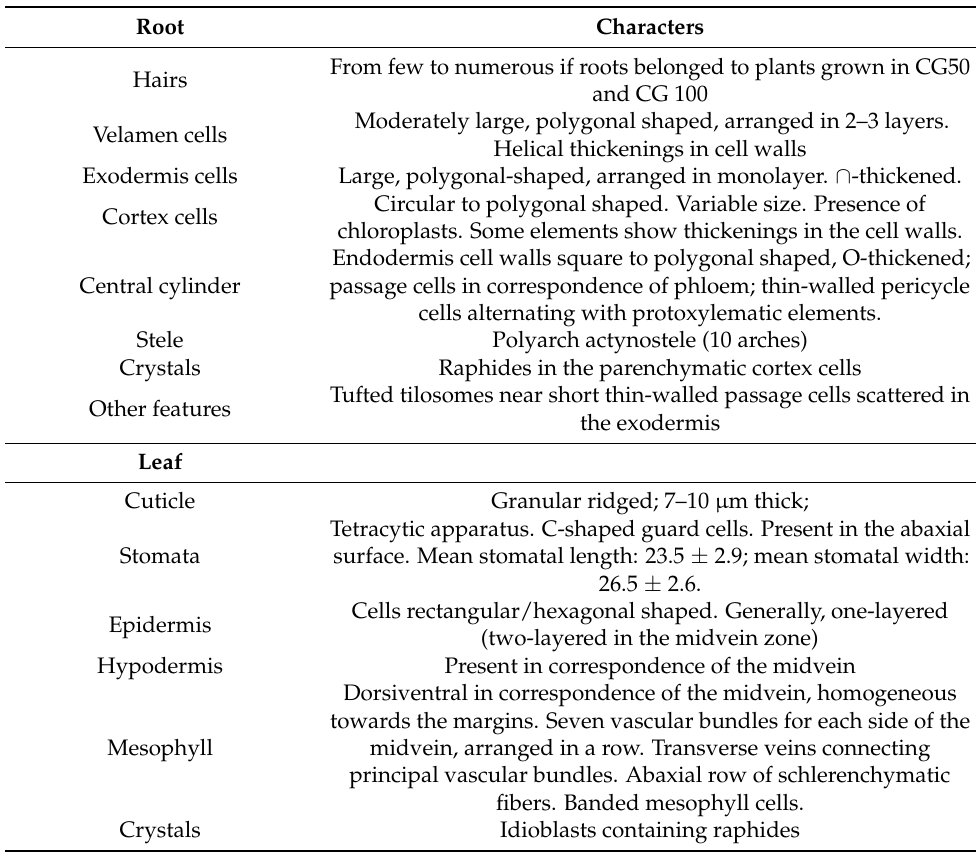
Table 3. General seedling’s root and leaf anatomical characters of Cattleya purpurata observed on all tested media (unless otherwise